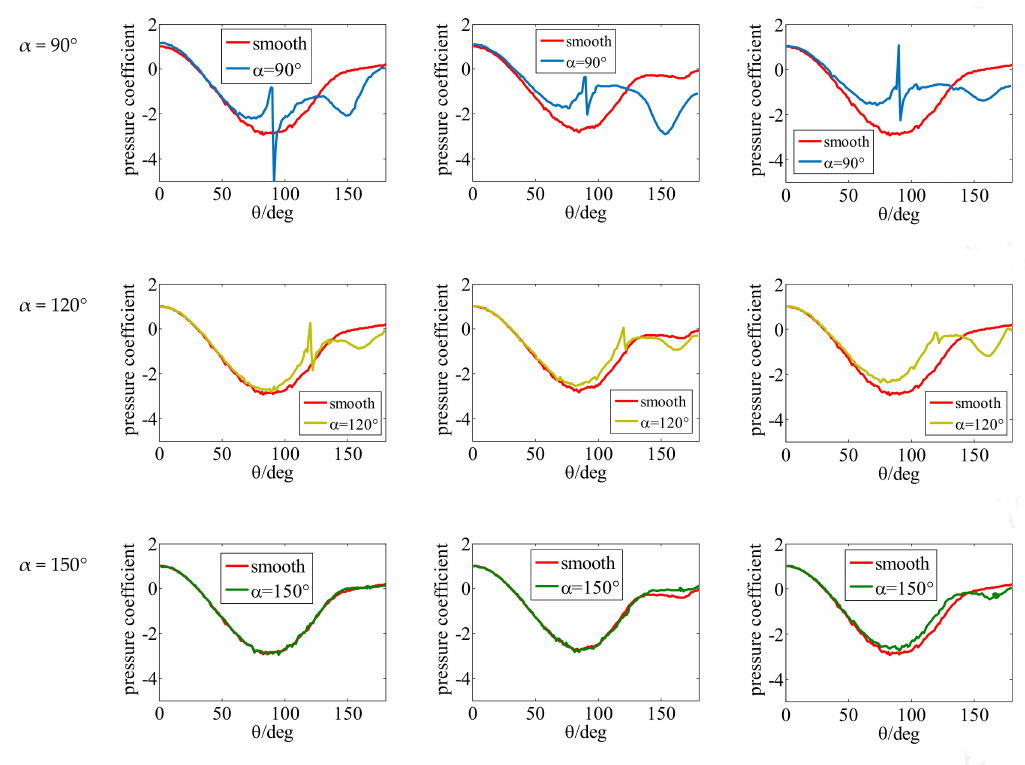
Figure 10. The comparison of the pressure coe ffi cient between the smooth cylinder and cylinder with strips for Re =